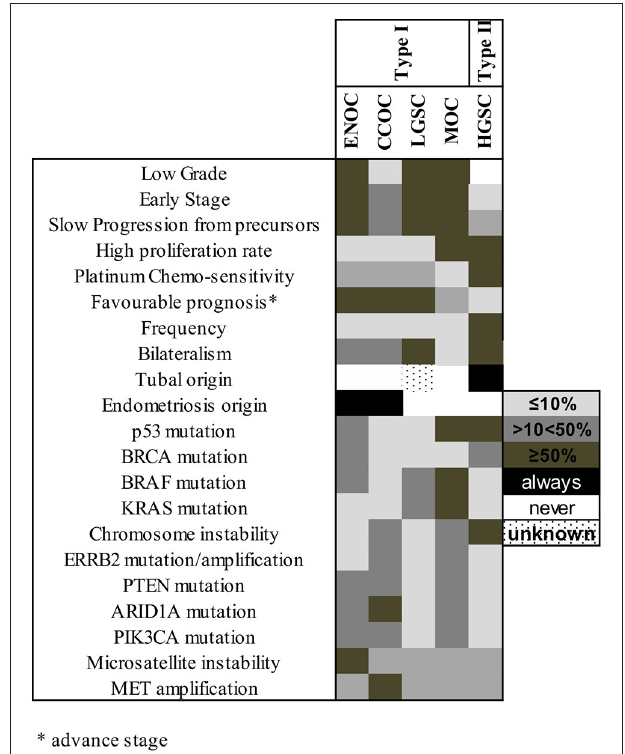
FIGURE 2 | Molecular factors and characteristics distinguishing type I and II tumors. The shade of each box represents the frequency of the characteristics listed at left in each subtype, grouped according to their previous type I/type II assignment. ENOC, endometrioid ovarian carcinoma; CCOC, clear cell ovarian carcinoma; LGSC, low grade serous carcinoma; MOC, mucinous ovarian carcinoma; HGSC, high grade serous